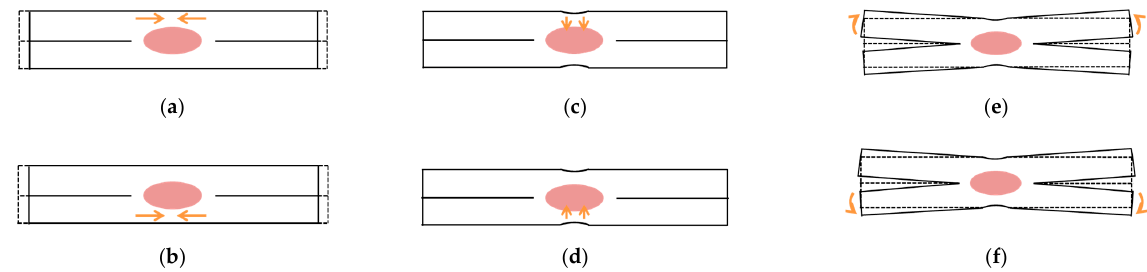
Figure 5. Deformation modes for RSW. ( a ) In-plane shrinkage (upper part); ( b ) In-plane shrinkage (lower part); ( c ) Out-of-plane shrinkage (upper part); ( d ) Out-of-plane shrinkage (lower part); ( e ) Out-of-plane bending (upper part); ( f ) Out-of-plane bending (lower part).